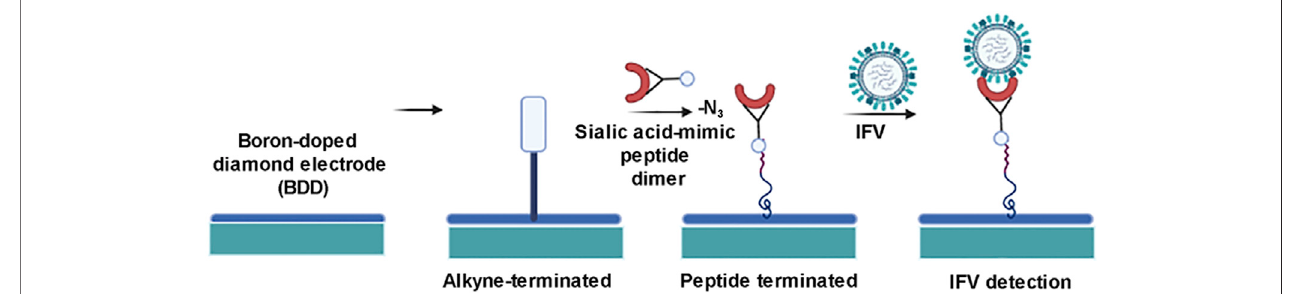
FIGURE 3 | Schematic diagram for detection of in fl uenza virus by boron doped diamond (BDD) nanobiosensor.